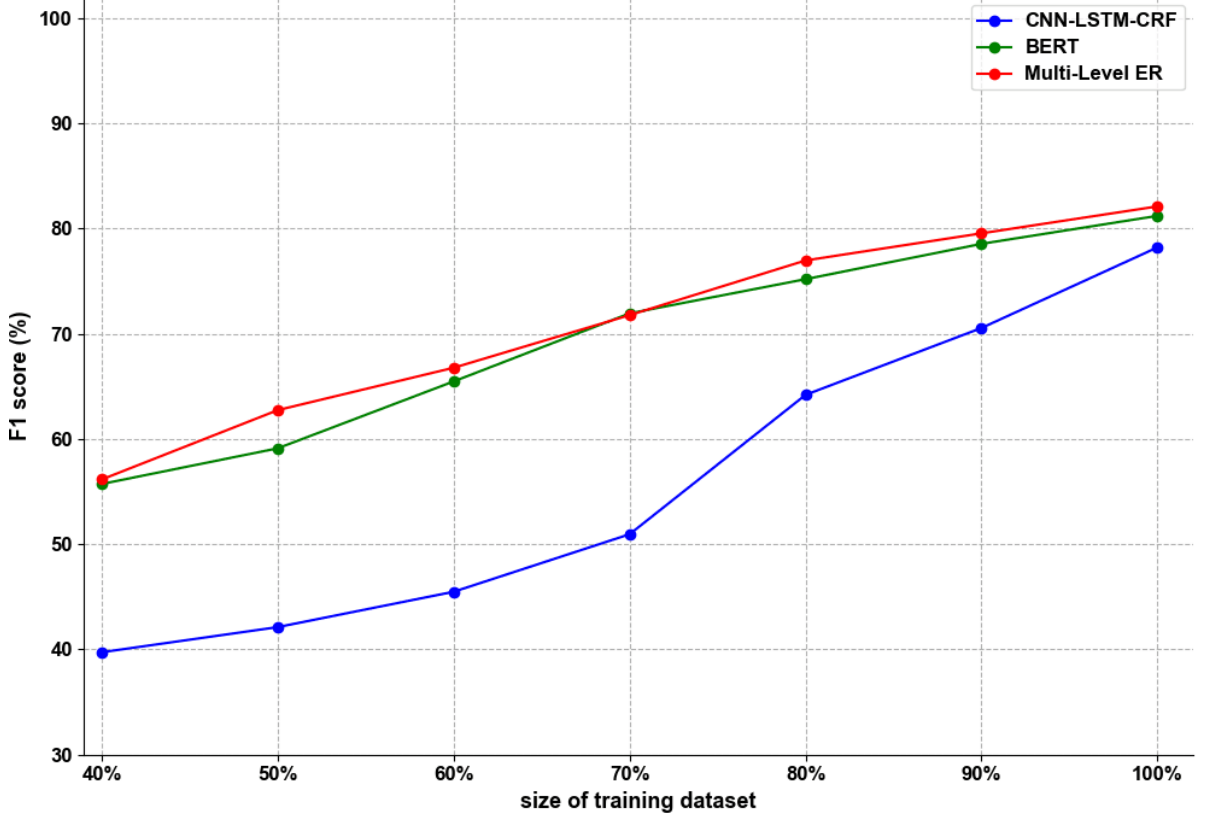
Figure 4. The effect of dataset size. BERT: Bidirectional Encoder Representations from Transformers; CNN: convolutional neural network; CRF: